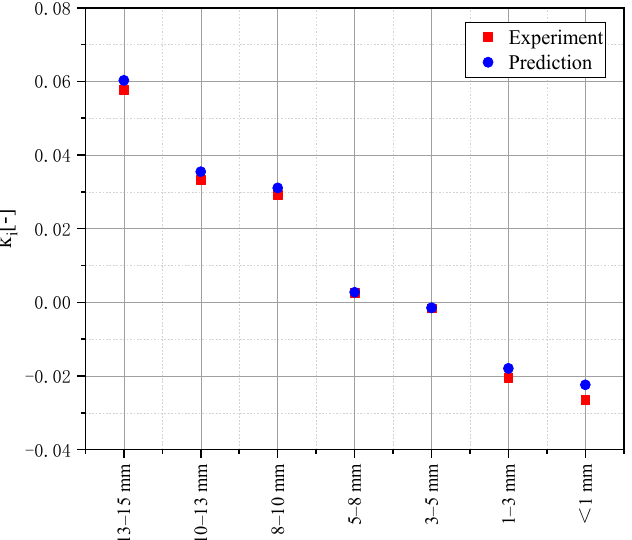
Figure 14. The predicted degradation rate and experimental value of different classes of nodules after running for 10 min in the experimental system (54 impacts).